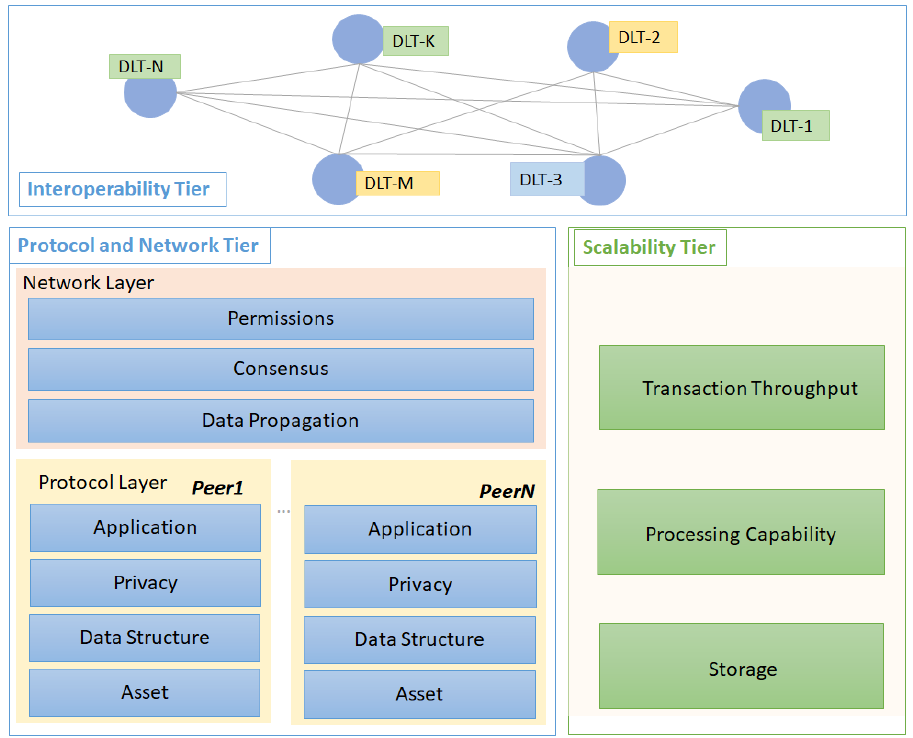
Figure 1. Three-tier architecture for decentralized applications development.